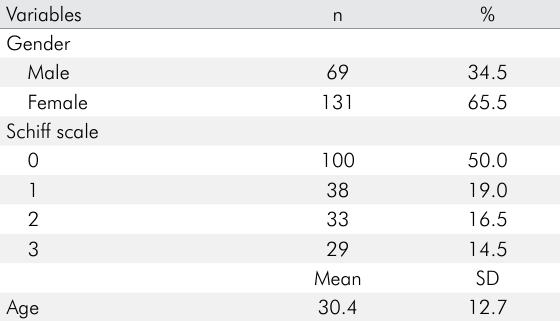
Table 1. Characteristics of the participants of the study.